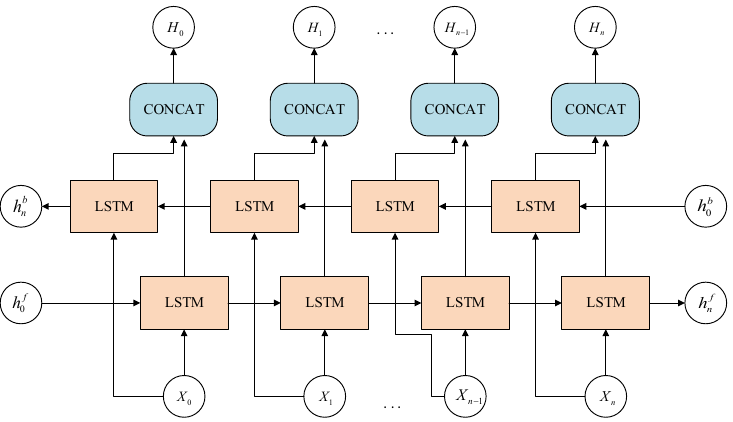
Figure 10. BiLSTM Model structure.